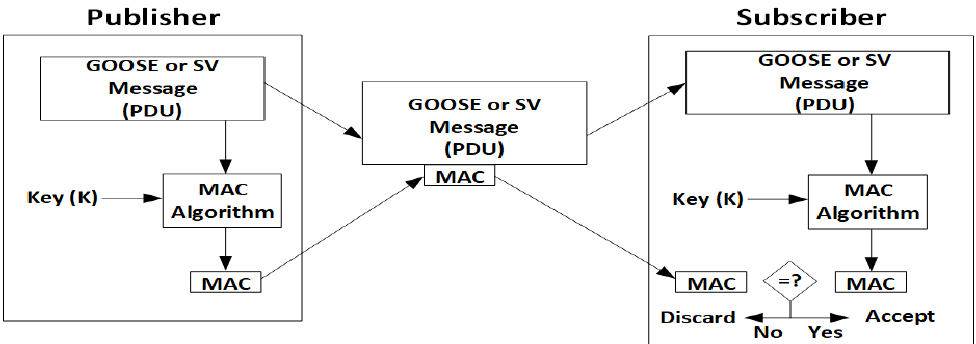
Figure 3. A process of MAC generation for SV and